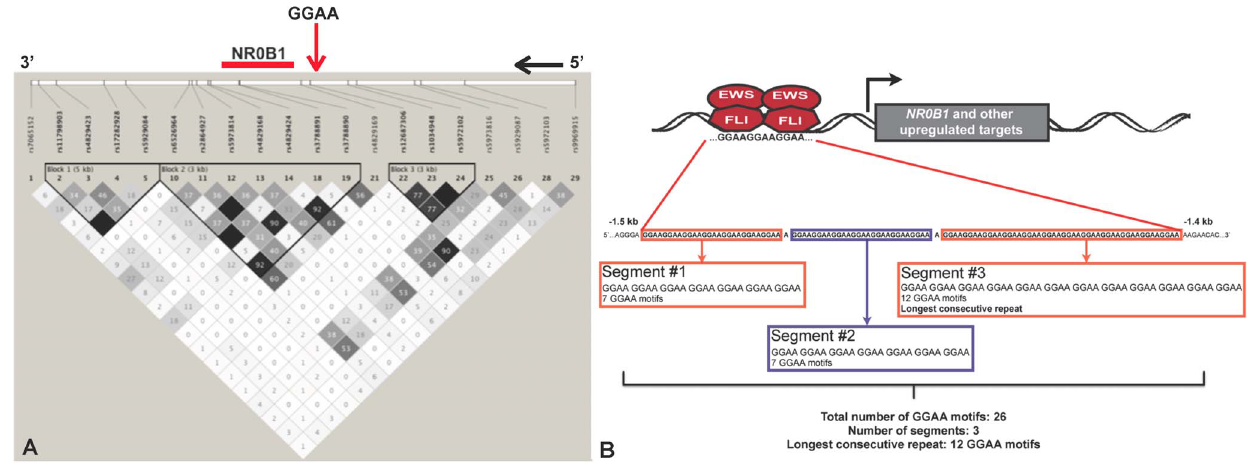
Figure 2. GGAA-microsatellite organization at the NR0B1 locus. ( A ) Using available single nucleotide polymorphism (SNP) data from the CEU reference population (northern and western European decent) of the International HapMap Project [24], the NR0B1 GGAA-microsatellite is identified within a defined haplotype block. ( B ) For the NR0B1 locus, the GGAA-microsatellite is located approximately 1.5 kb upstream of the transcriptional start site (TSS) and is characterized a variable number of contiguous GGAA motifs, partitioned by single adenosine base substitutions. Sequence characteristics of interest include the total number of GGAA motifs, the total number of contiguous segments and longest consecutive GGAA segment. Figure panel adapted from [12].